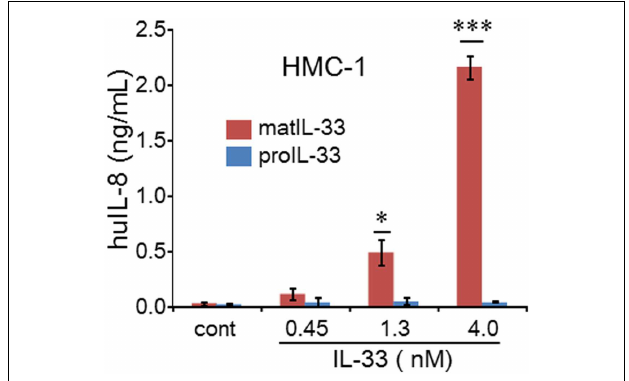
FIGURE 7 | Mean ± SEM levels of IL-8 released from human HMC-1 cells . HMC-1 cells were stimulated for 24h with increasing concentrations of either mature or precursor form of IL-33 as indicated under the horizontal axis (* p < 0.05; *** p < 0.001). Representative data from one of two independent experiments performed in triplicate are